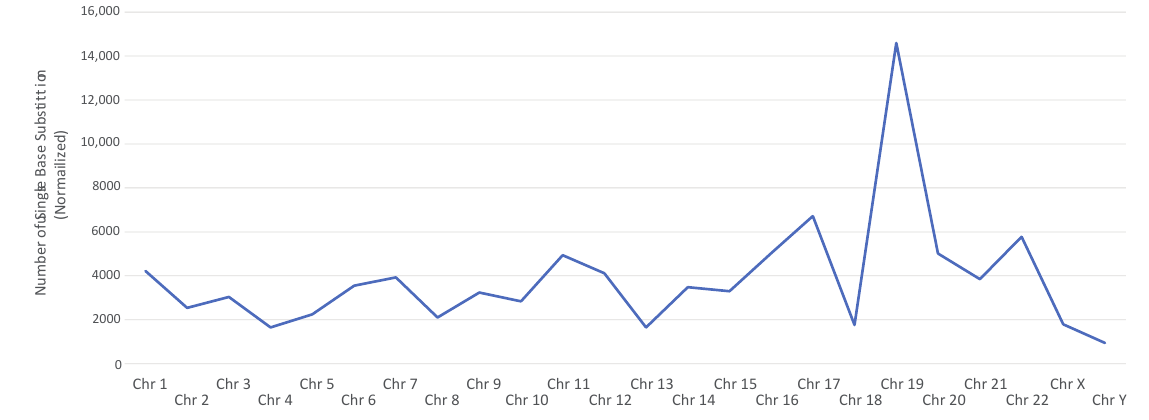
Figure 1. Single base substitution frequency by chromosome. Plot of the normalized average number of point substitutions across samples by chromosome number.